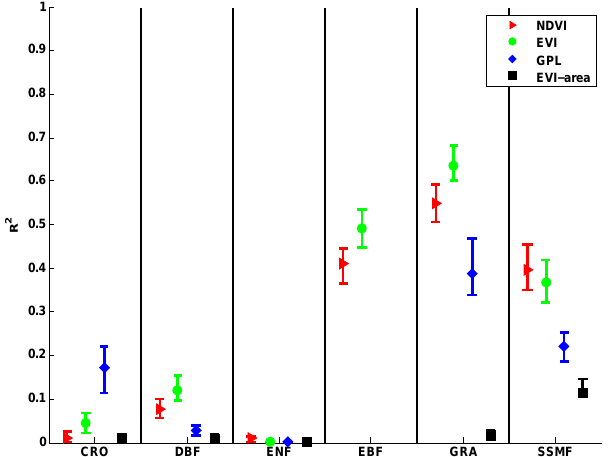
Fig. 5. R 2 between relative interannual anomalies in tower GPP and the four proxies. GPL and EVI-area were not evaluated in